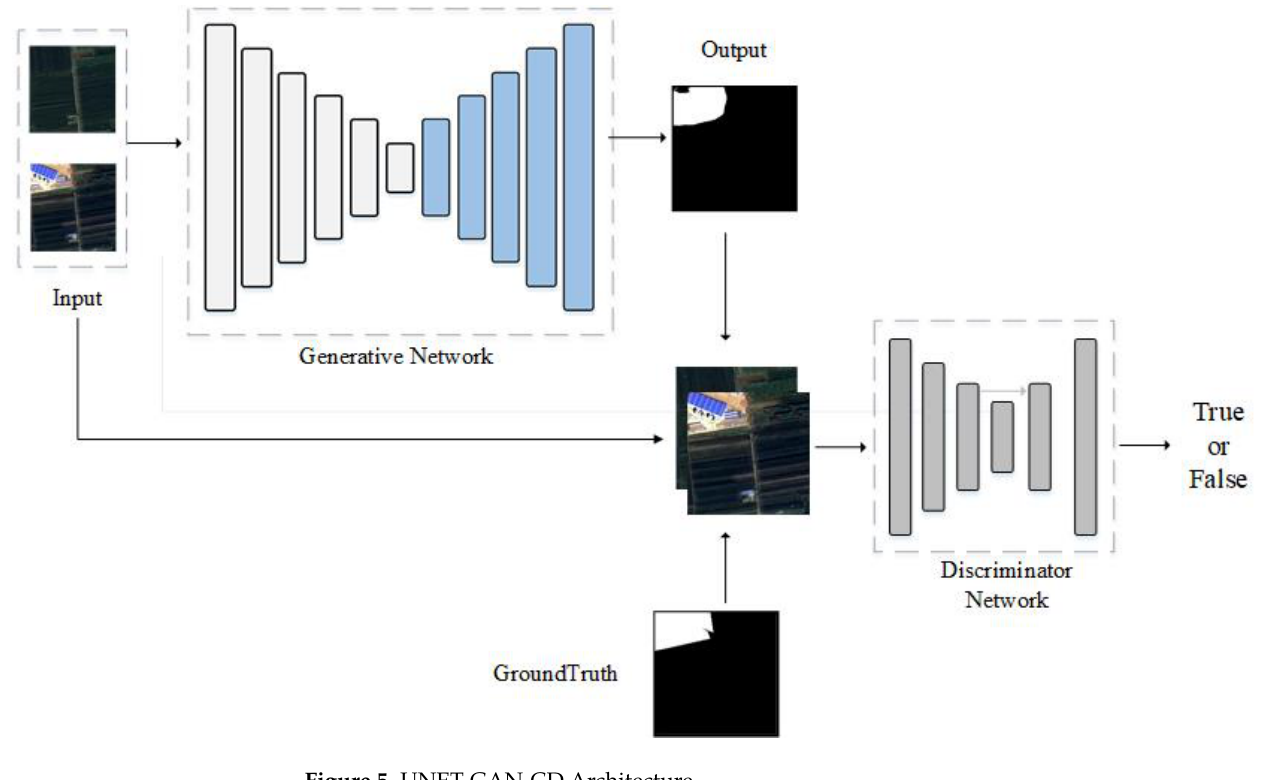
Figure 5. UNET-GAN-CD Architecture.